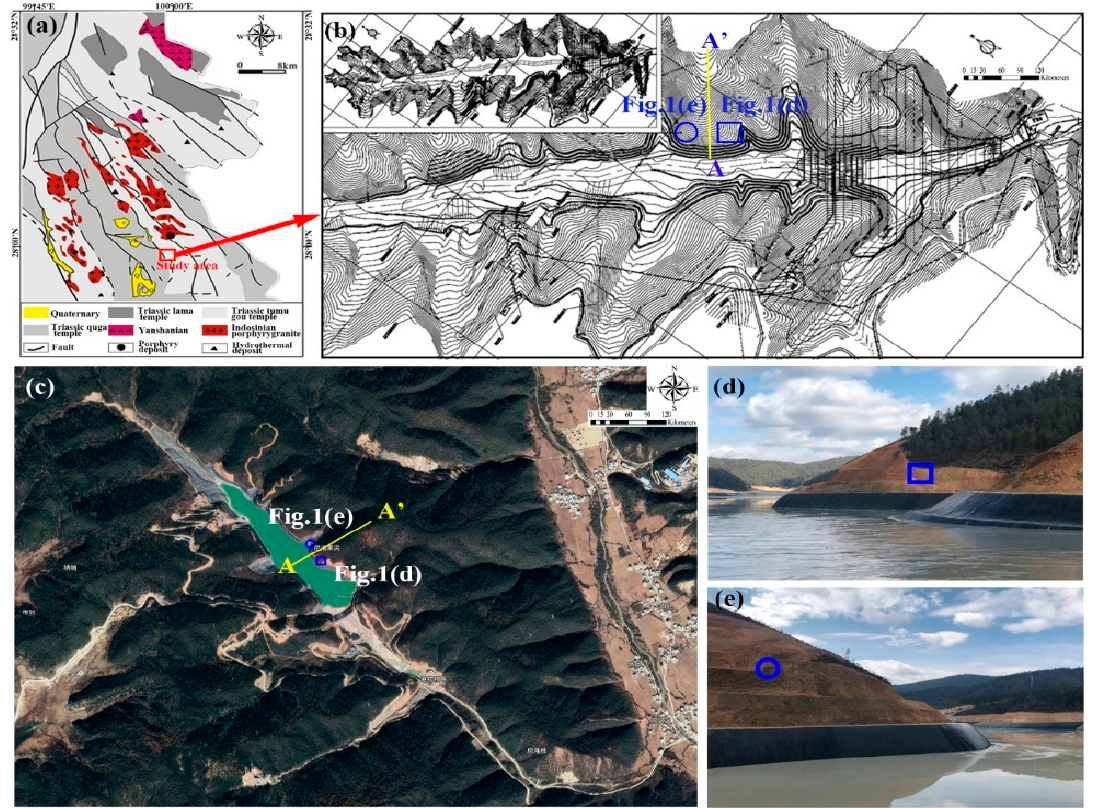
Figure 2. Geographic location of the study area: ( a ) Study area location; ( b ) contour map of rock slope; ( c ) topography of rock slope; ( d ) right elevation of rock slope; ( e ) left elevation of rock slope.